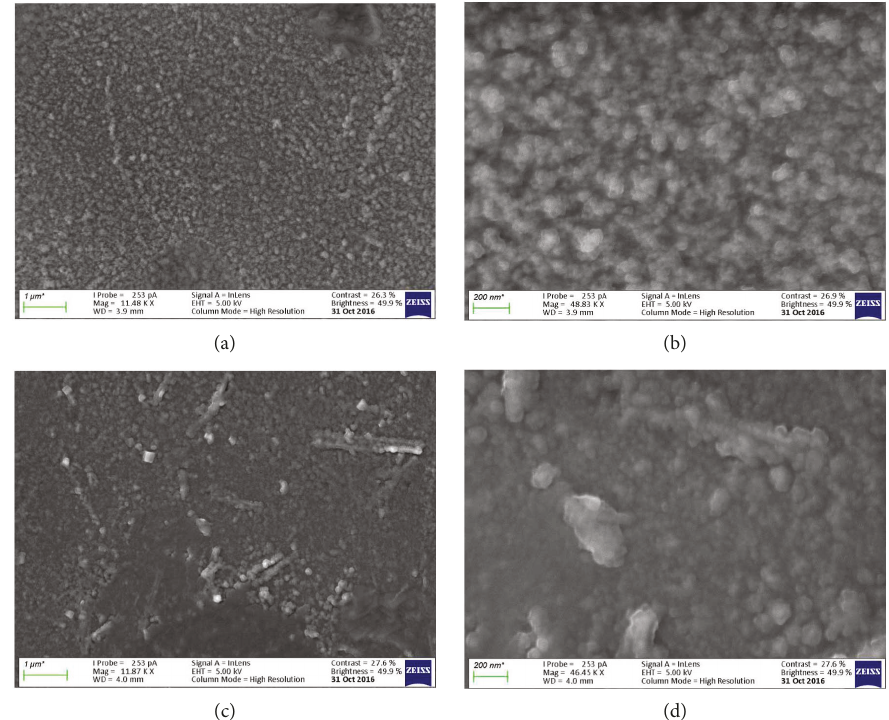
Figure 5: SEM of (a) NiO thin fi lm at lower magni fi cation, (b) NiO thin fi lm at higher magni fi cation, (c) fabricated NiO/TiO solar cell at lower magni fi cation, and (d) fabricated NiO/TiO